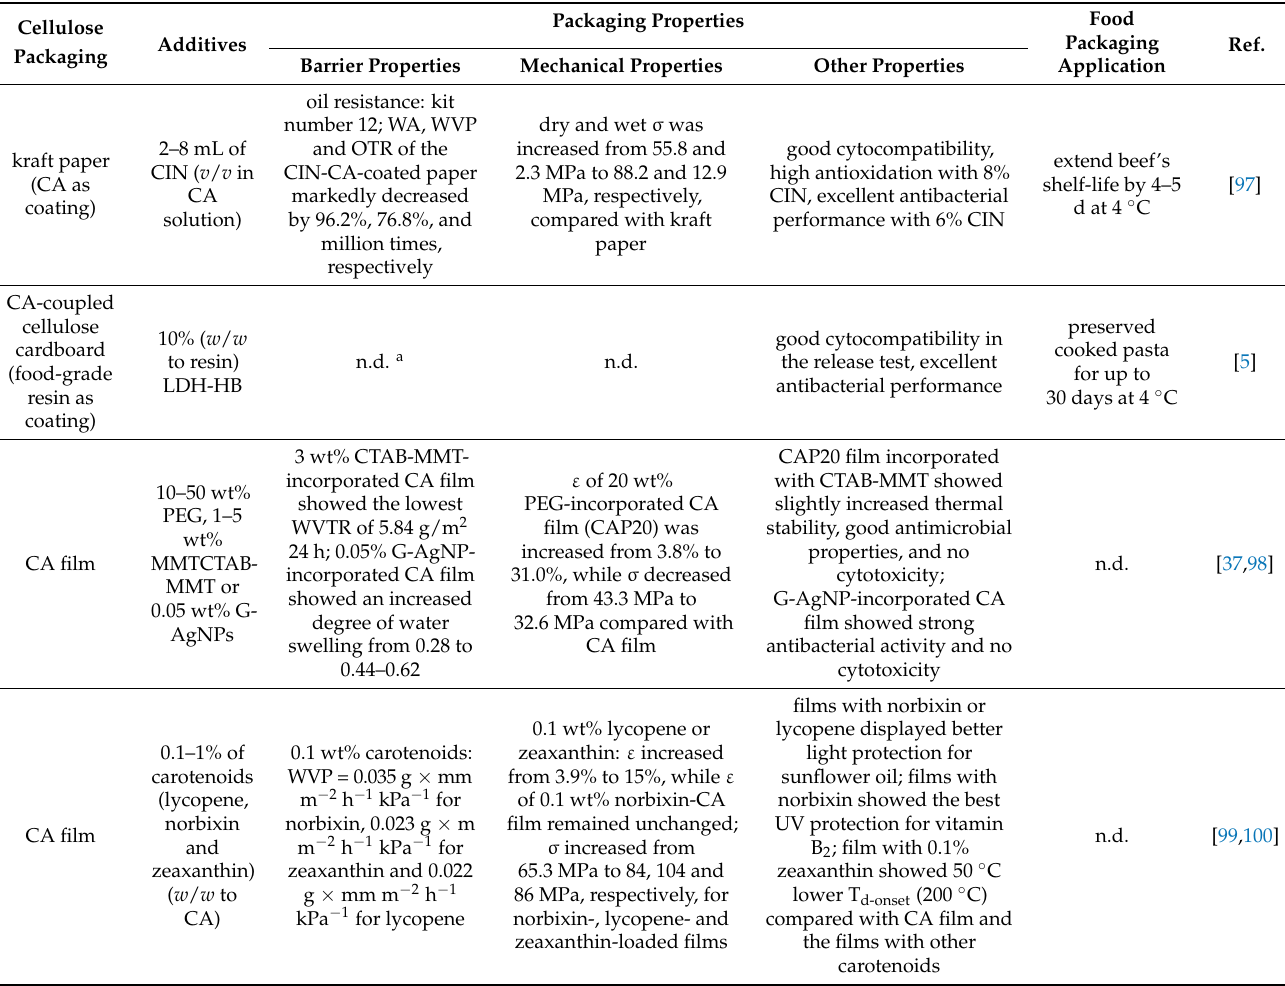
Table 3. Overview of C2–C6 CES materials in food packaging